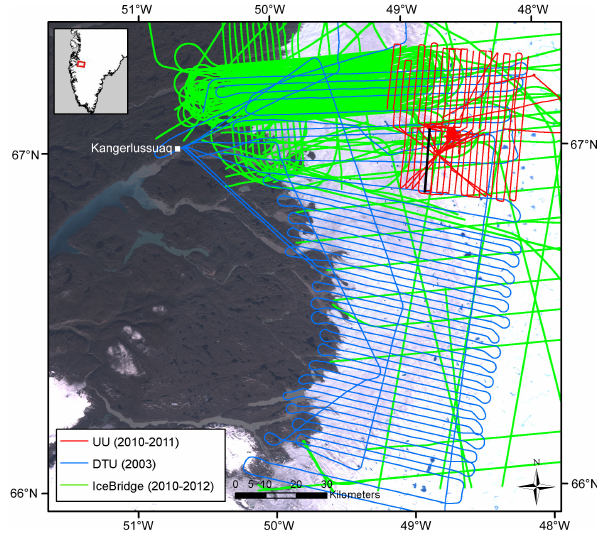
Figure 1. Data sources consisting of ground-based radar surveys (UU data set) and airborne surveys (DTU and IceBridge data sets) collected between 2003 and 2012. The airport and town of Kanger- lussuaq are also marked on the map. The black line in the UU data set indicates the location of the profile in Fig. 2. Table 1. Radar system parameters for each data